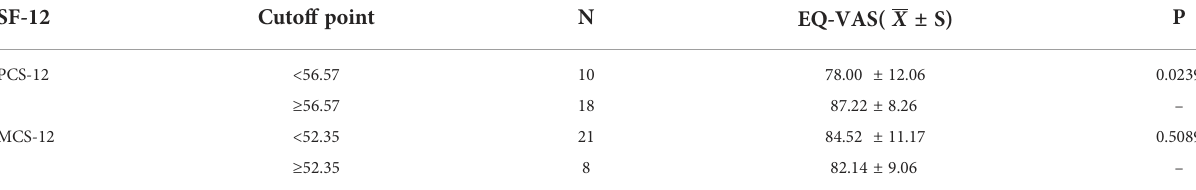
TABLE 6 Comparison of EQ-VAS scores for the “ best health status ” respondents by PCS-12 and MCS-12 median grouping.